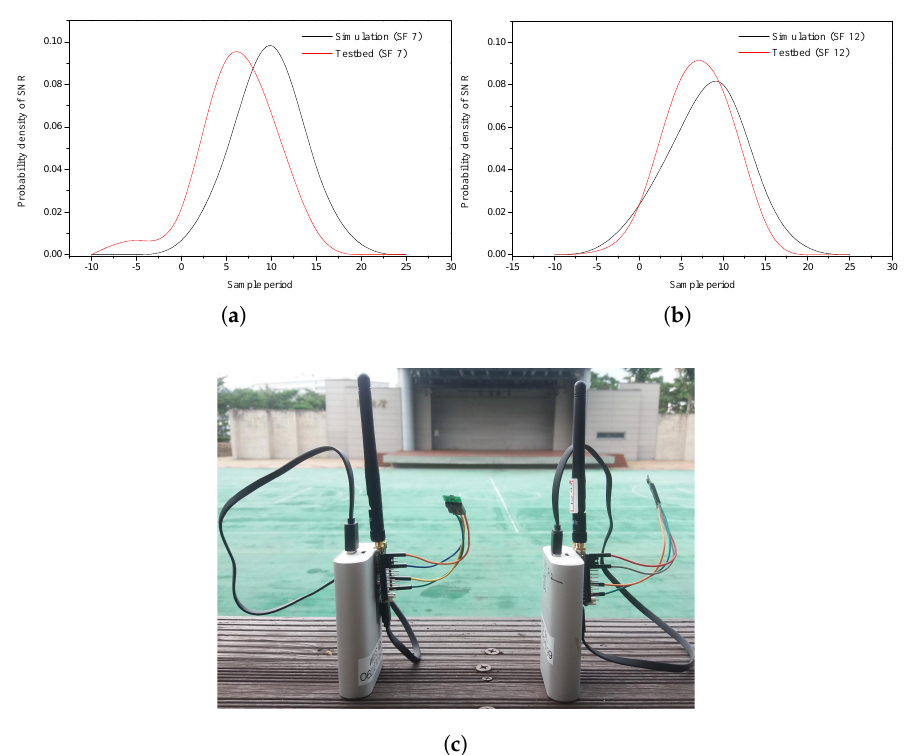
Figure 4. The probability density function (PDF) of the SNR of M packets received at the network server using real-time experiment and computer simulation: ( a ) PDF of SNR using SF7; ( b ) PDF of SNR using SF12, and ( c ) deployment of two EDs with SF7 and